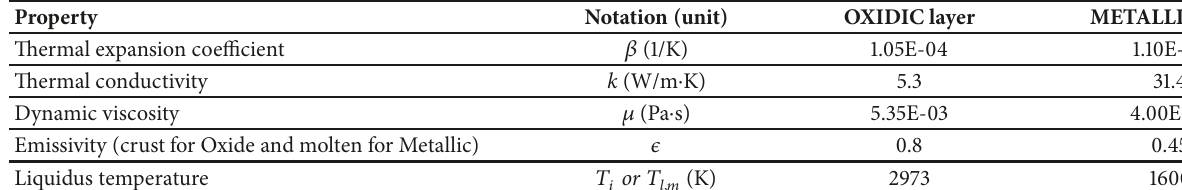
Table 4: Properties of oxidic and metallic layers assumed in analytical calculations.